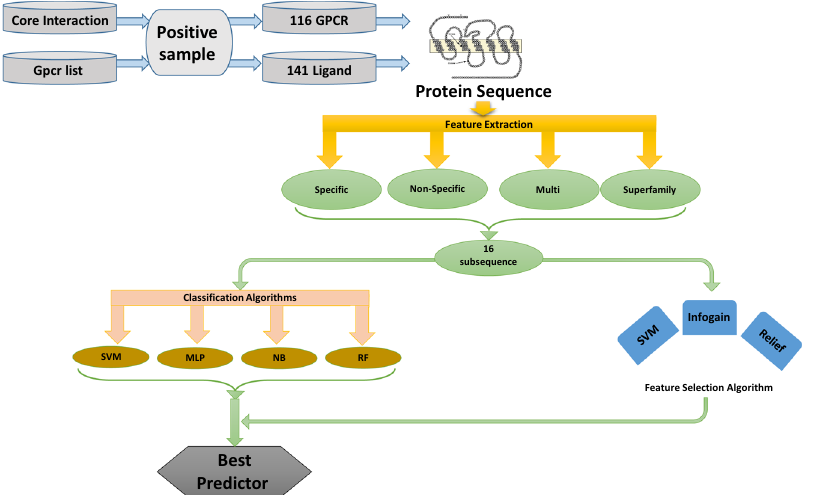
Figure 2: Overall illustration of the proposed approach for GPCR-ligand interacting pairs.